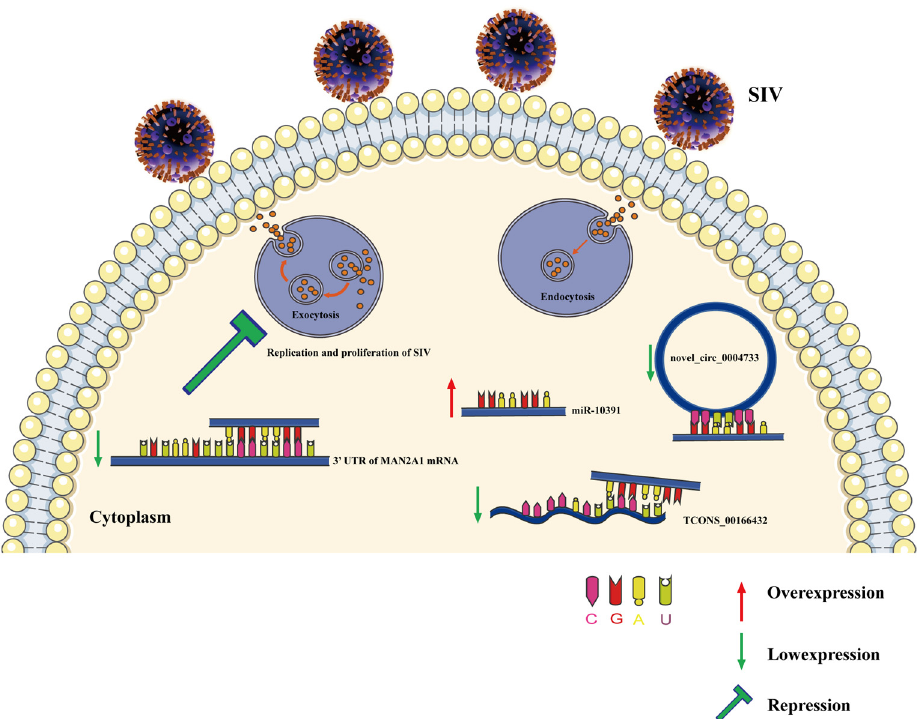
Figure 6. A schematic model displaying the role of TCONS_00166432/novel_circ_0004733-miR-10391-MAN2A1 in 3D4/21 cells infected by SIV.